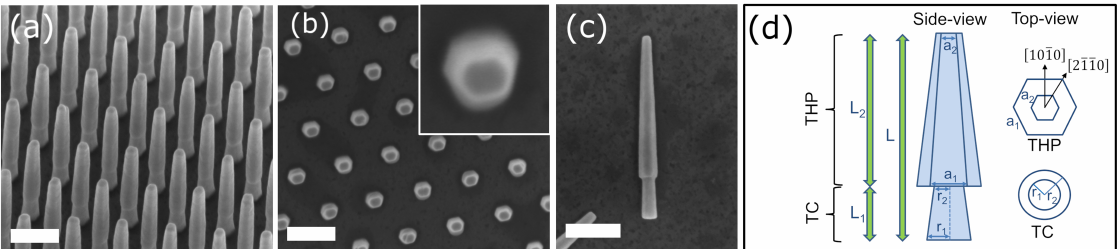
Figure 3. Tilted ( a ) and top-view ( b ) scanning electron micrographs of vertical ZnO nanowires grown on an atomic layer deposited ZnO on GaN/c-Al 2 O 3 (0001). Hexagonal top and lower facets are shown in the magnified image ( b inset). Side view image taken on a lying nanowire, illustrating the non-uniform cross section along the vertical axis ( c ). The length of the white scale bars was 500 nm. The geometry of the nanowires was divided into a lower truncated cone (TC) and an upper truncated hexagonal pyramid (THP) during the evaluation of the bending experiment ( d ).